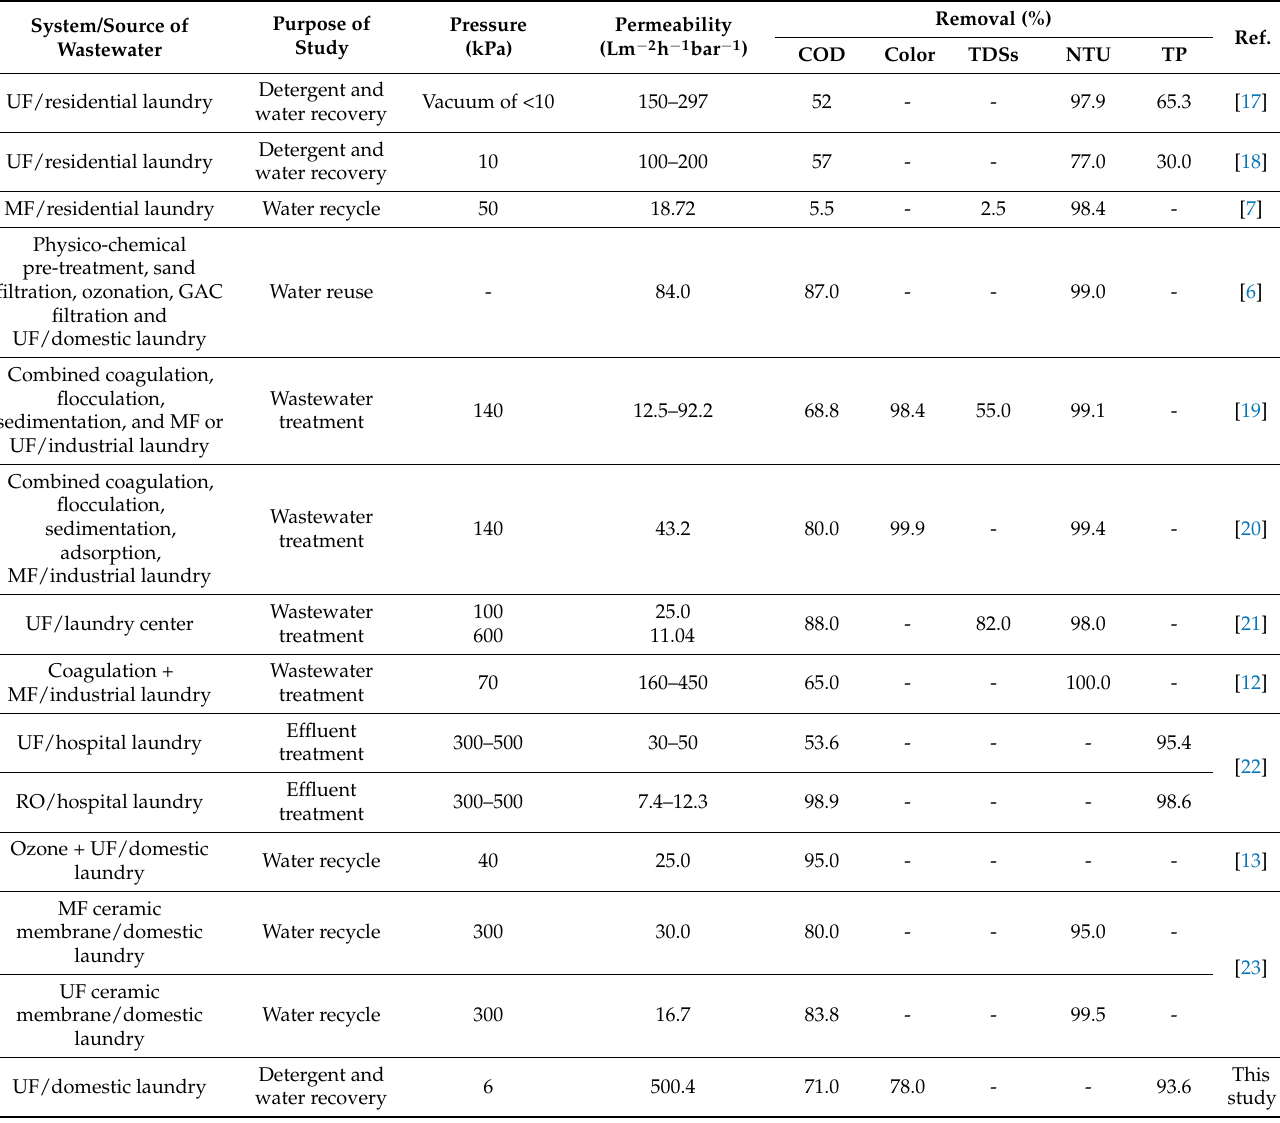
Table 1. Recent studies on the treatment of laundry wastewater for water and/or detergent